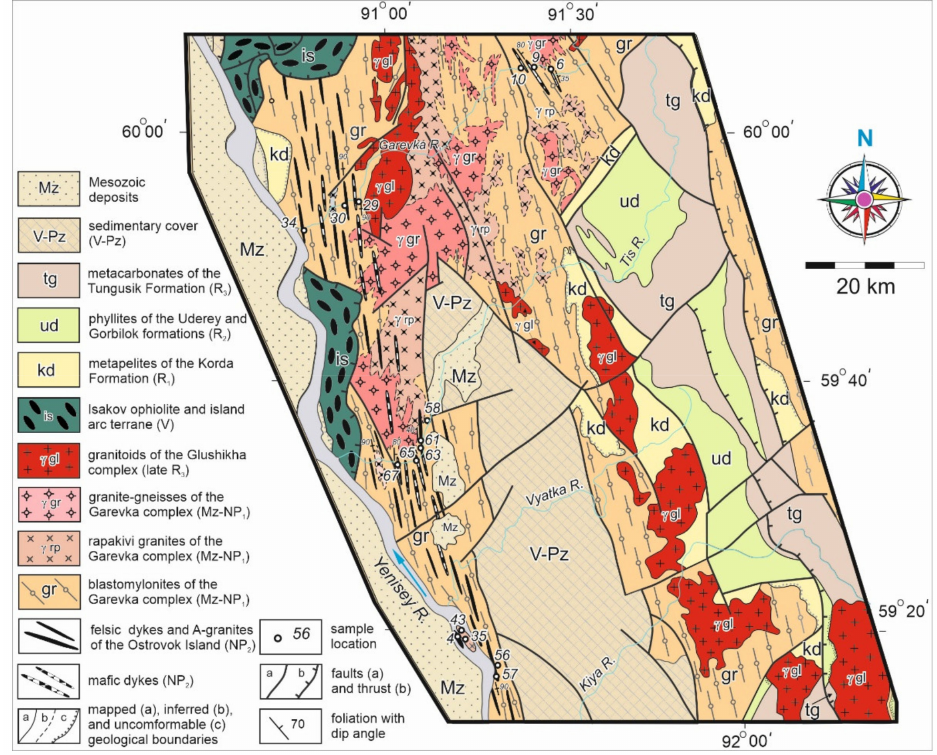
Figure 5. Geological sketch map of the rocks of the Garevka complex within the Yenisey regional shear zone, showing sample